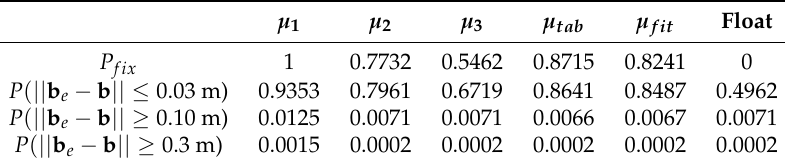
= 0.01 for µ tab and µ fit . b e denotes the estimated baseline f